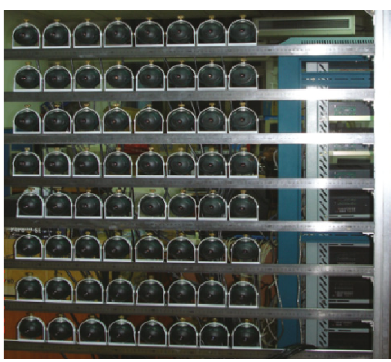
Figure 2: Our camera